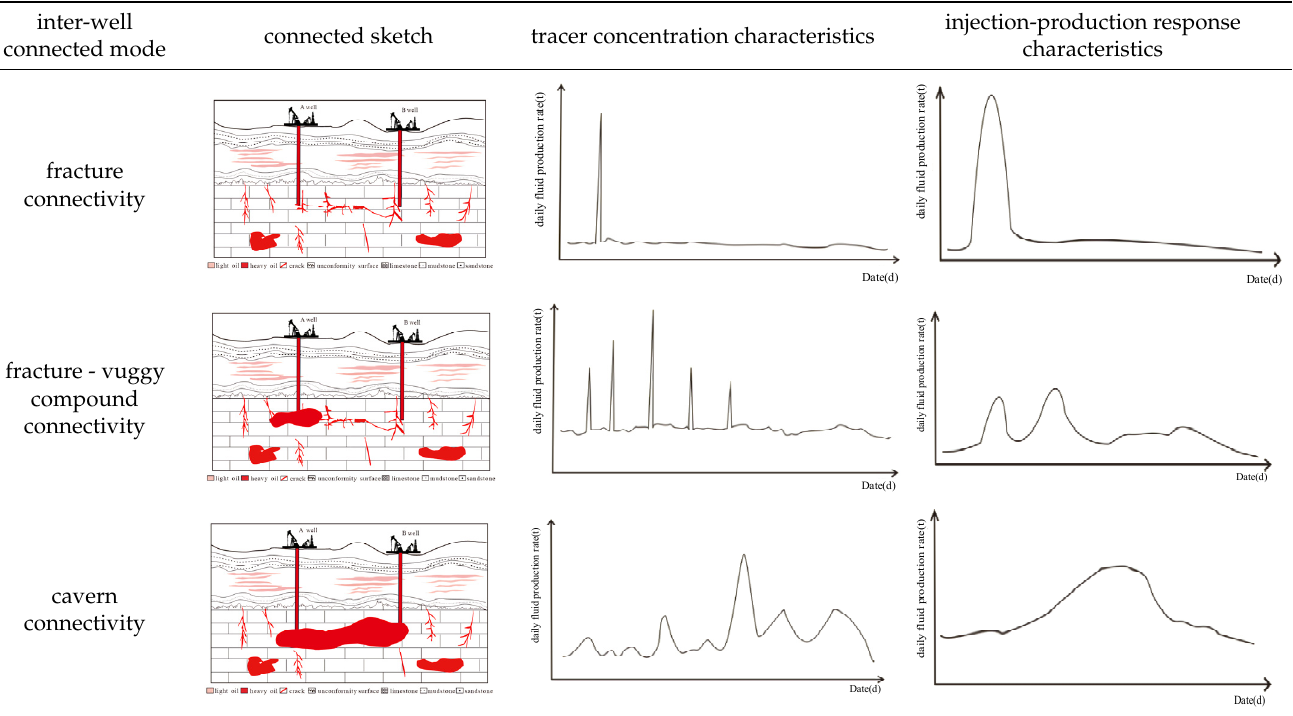
Table 1. The characteristics of tracer concentration and production under different interwell- connected mode.